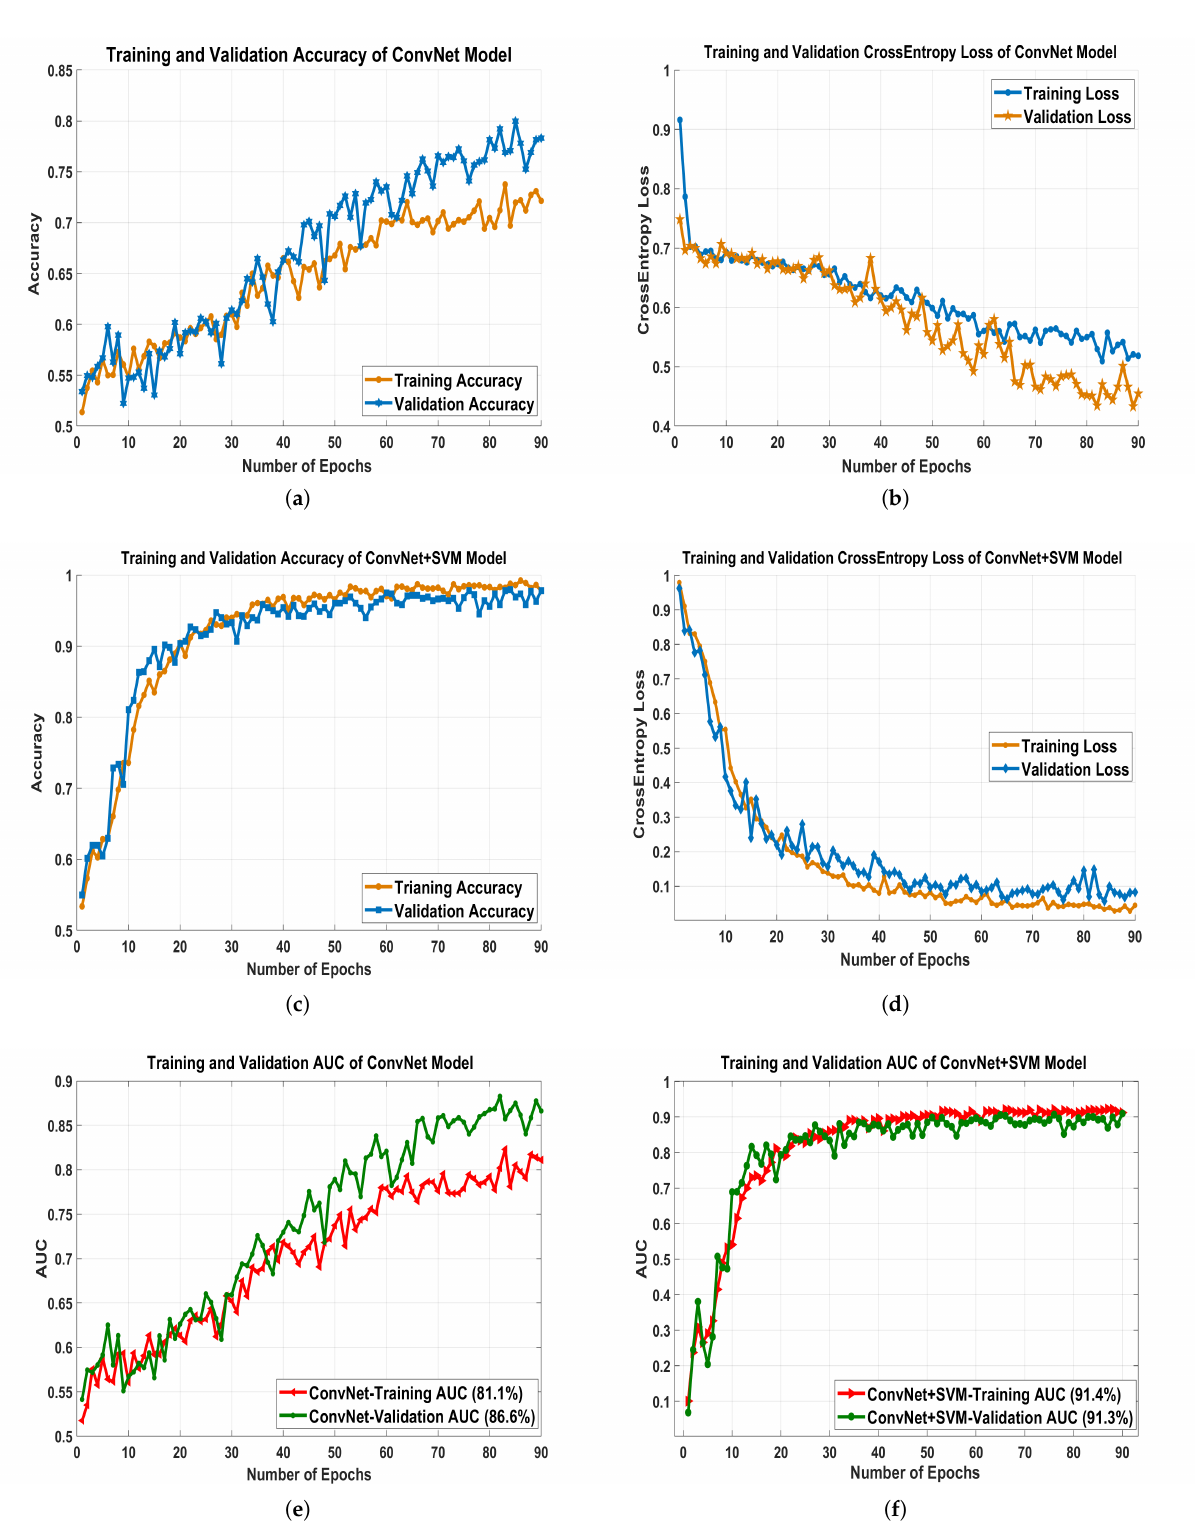
Figure 7. The figures represent the evaluation measures of breast mass detection and classification framework based on the ConvNet architecture. ( a ) Training and validation accuracy; ( b ) training and validation cross-entropy loss; ( e ) AUC, and evaluation measures of breast mass detection and classification framework based on ConvNet+SVM architecture; ( c ) training and validation accuracy; ( d ) training and validation cross-entropy loss; ( f )